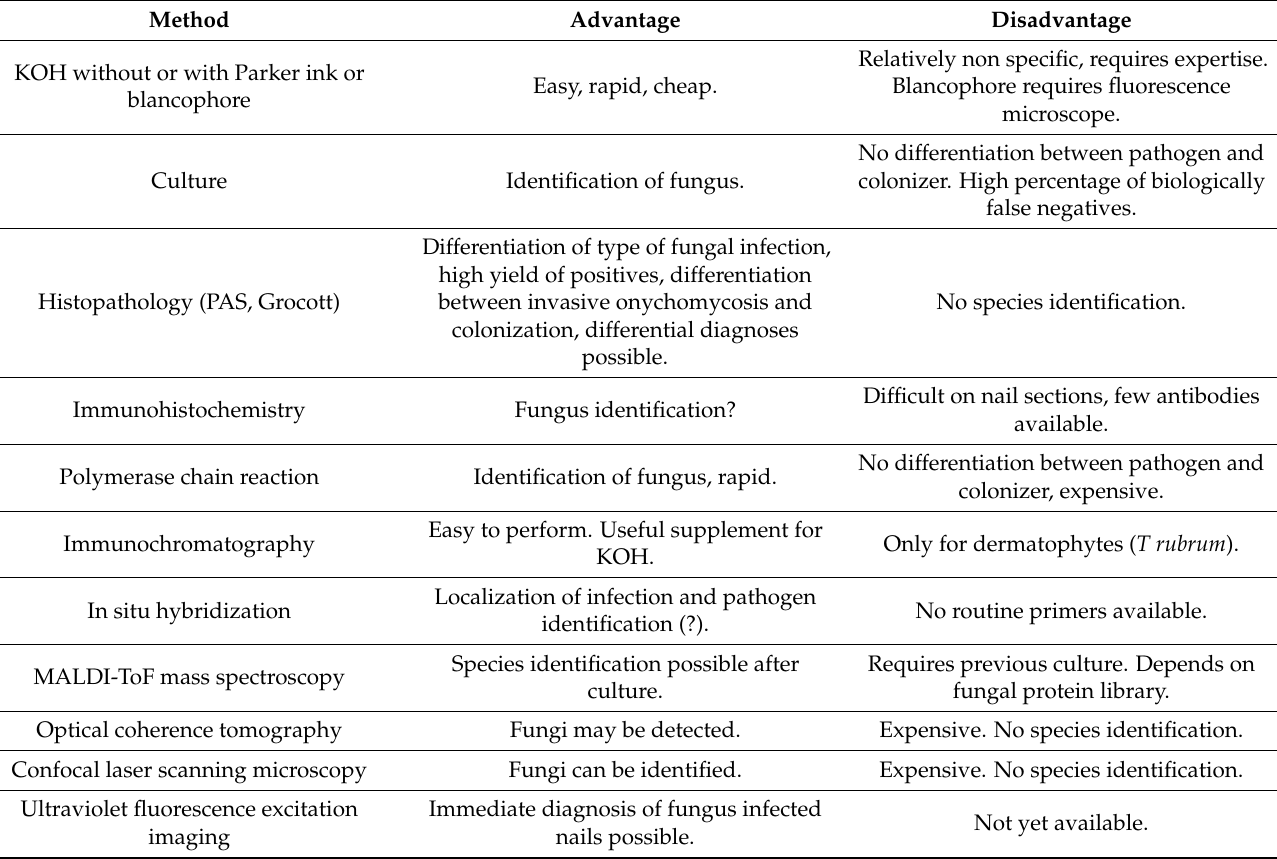
Table 3. Techniques for the identification of fungal nail infections